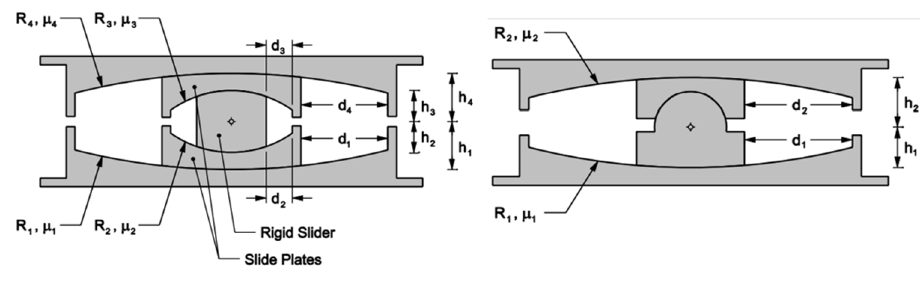
Figure 12. MSFS with four and two sliding surfaces [43–45].